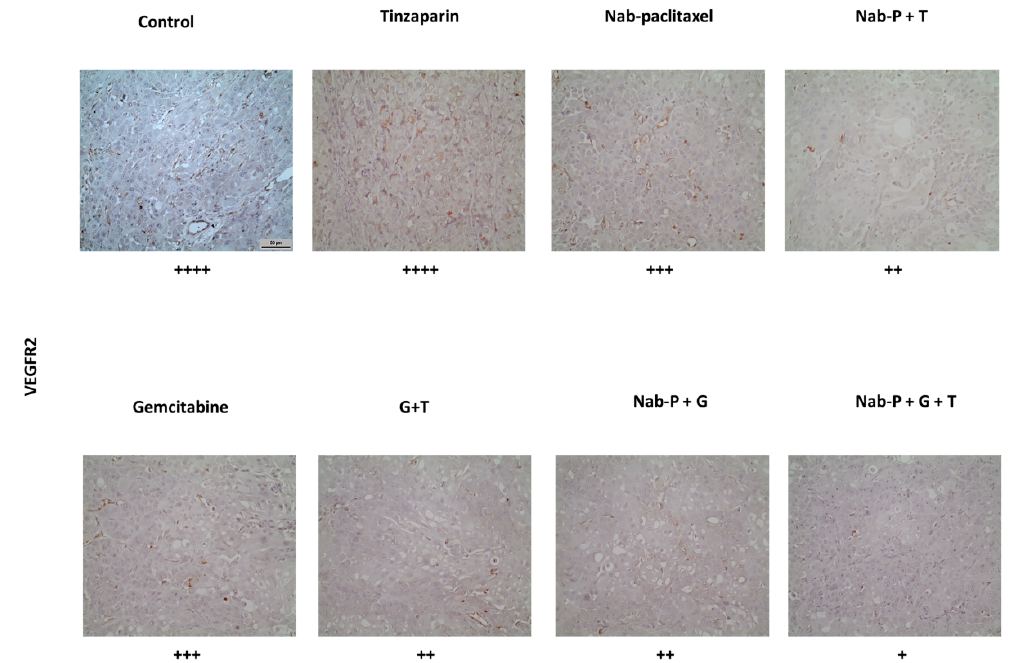
Figure 6. Tinzaparin augments further decrease in neoangiogenesis when added to double or triple combinations. Repre- sentative photos of each group (control, tinzaparin, nab-paclitaxel, nab-paclitaxel + tinzaparin, gemcitabine, gemcitabine + tinzaparin, nab-paclitaxel + gemcitabine, nab-paclitaxel + gemcitabine + tinzaparin) after staining with anti-VEGFR2 at paraffin sections. Symbols are denoted as: + low expression, ++ mid expression, +++ high expression, ++++ abundant expression. n = 5/group, 200× magnification, scale bar = 50 μ m.